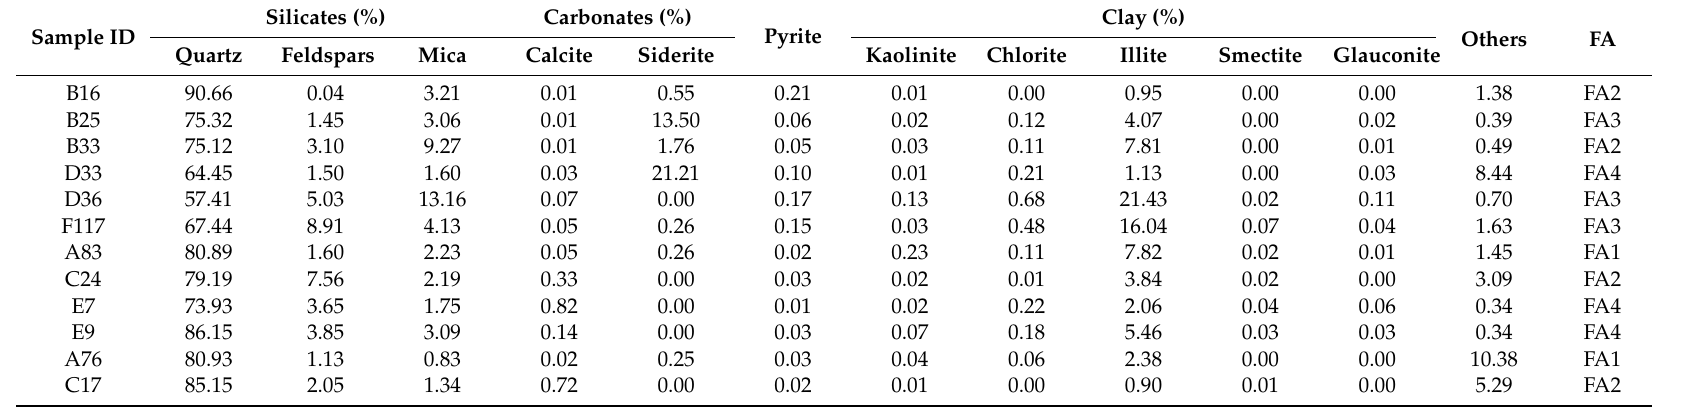
Table 2. Mineralogy compositions of the samples in each of the